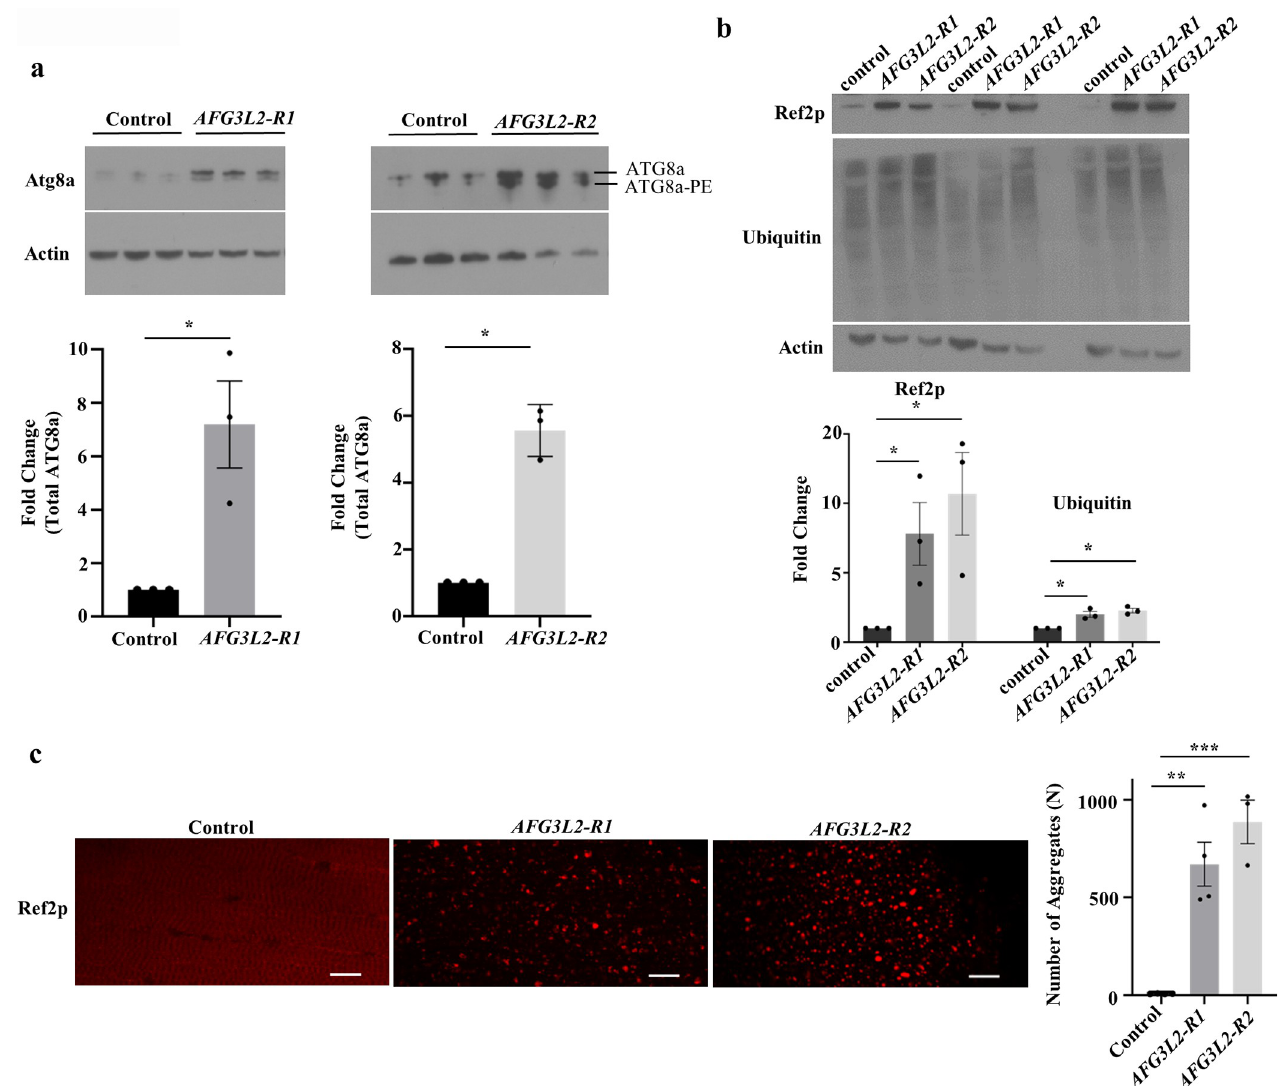
Fig 8. Macroautophagy is induced in AFG3L2 -deficient animals. Western blot analysis of cell lysates from control (UAS- LUCIFERASE RNAi/da-Gal4) and AFG3L2 -deficient (UAS- AFG3L2-R1 RNAi; da-Gal4 and UAS- AFG3L2-R2 RNAi/da-Gal4) pupae using antiserum to ATG8a (a) , Ref(2)p (b) and ubiquitin (b). The lower of the two bands detected by the anti-ATG8a antiserum (designated ATG8a-PE) represents a phosphatidylethanolamine conjugated form of Atg8a, whereas the upper band represents the unconjugated form of the ATG8a. Antiserum against Actin was used as a loading control (N = 3 independent groups of 5 pupae, � p < 0.05 by one-way ANOVA Tukey’s test for multiple comparison). c. Confocal images of indirect flight muscles from Control (UAS- LUCIFERASE RNAi/da-Gal4) and AFG3L2 -deficient (UAS- AFG3L2-R1 RNAi; da-Gal4 and UAS- AFG3L2-R2 RNAi/da-Gal4) pupae using antisera against Ref(2)p. Scale bars are 5 μ m. The right panel indicates the average number of Ref(2)p punctate (N = 4 for control and AFG3L2-R1 animals and N = 3 for AFG3L2-R2 animals, �� p < 0.005 and ��� p < 0.0005 by one-way ANOVA Tukey’s test for multiple comparison).